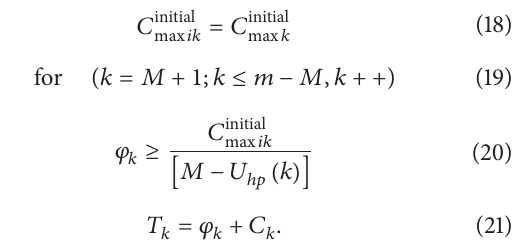
lesser computation time and lesser interrelease time. It